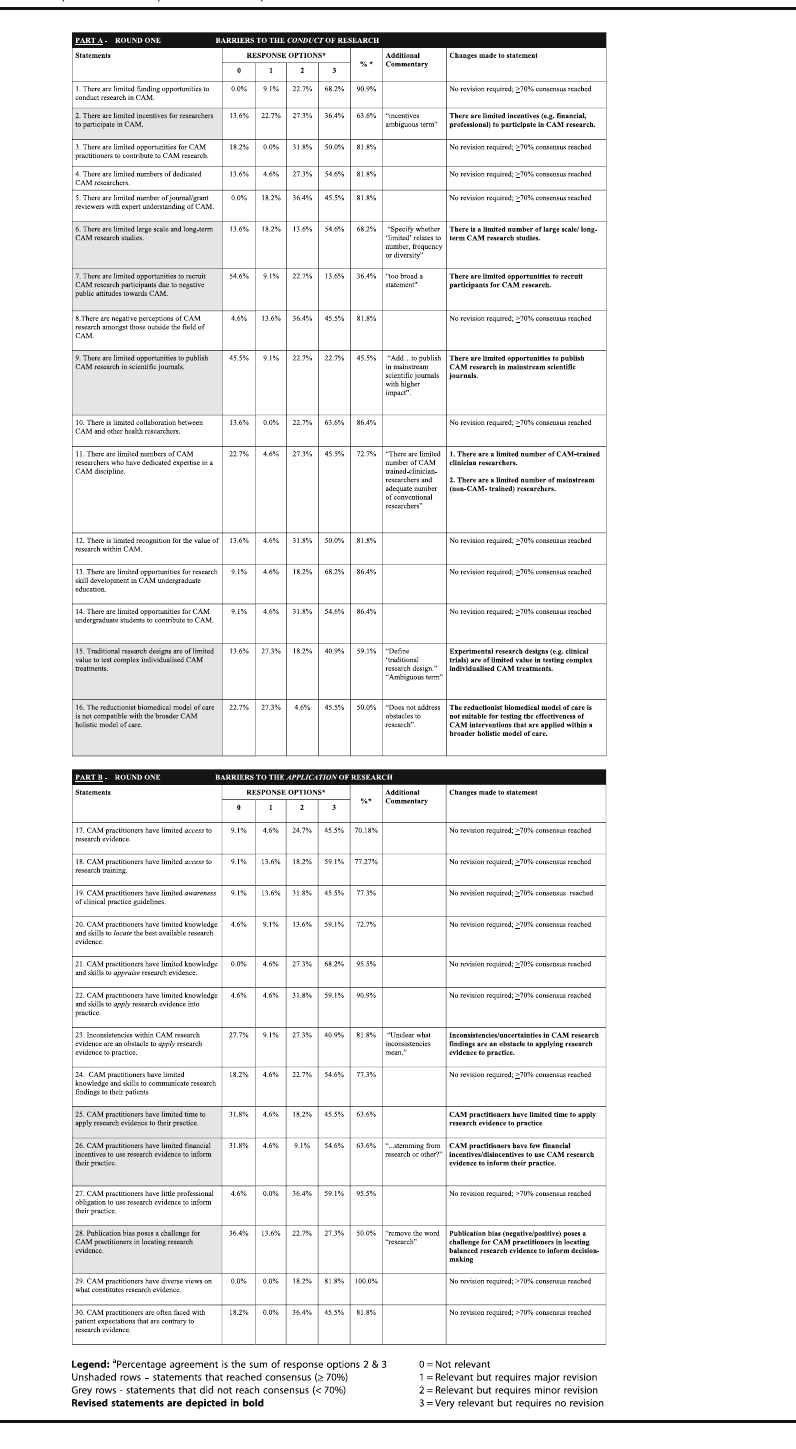
Table 3 Overview of participant responses to part A and part B items from round